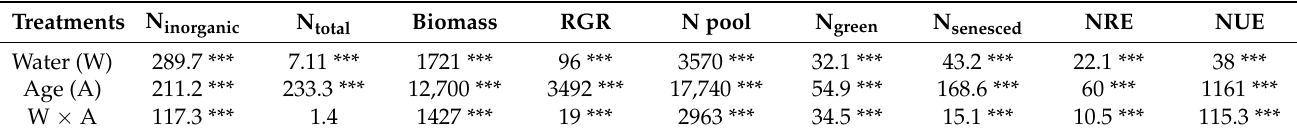
Table 4. Results ( F value) of two-way ANOVA on the effects of water supply (W), plantation ages (A) and their interactions on soil N, plant biomass and plant N traits.